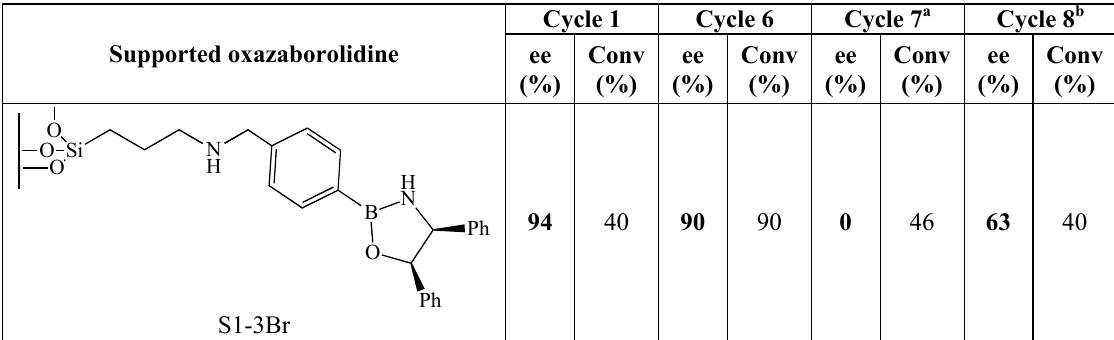
Table 10. Regeneration of the supported